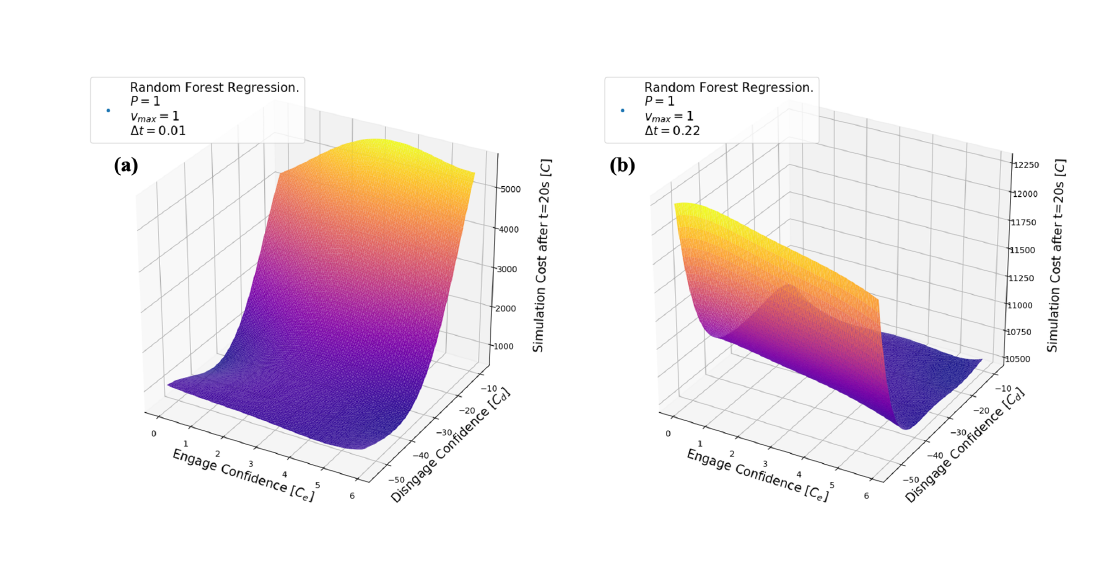
Figure 6. Illustration of 3D cross sections of the 6D best-fit hypercurve for the cost of a simulation obtained using Linear Multivariable Polynomial Regression. The colormap indicates higher confidence values with warmer (yellower) colors. 3 of the simulation variables ( P , v max , and ∆ t ) were kept constant at the values shown in the legend, while the two others C e and C d were graphed with the equivalent cost in the z -axis. ( a ) Cross section of arbitrarily chosen lower ∆ t value, where cost appears to be at a low value. ( b ) Cross section of arbitrarily chosen higher ∆ t value, where cost appears to be higher on average than ( a